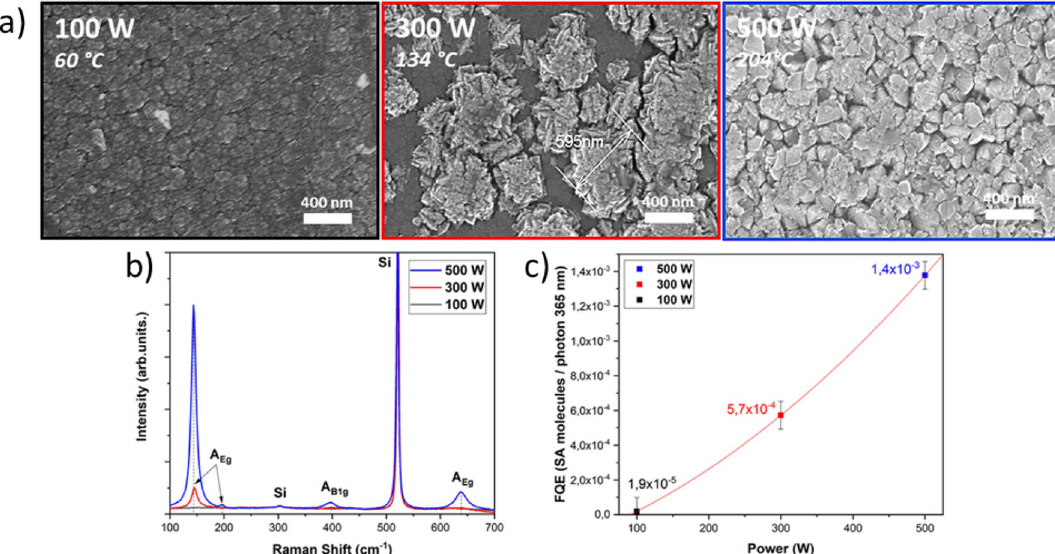
Figure 2. SEM topviews with associated T sub max ( a ), Raman scattering spectra ( b ) and Photocatalytic activity ( c ) of TiO 2 deposited at different RF power (2 h CW mode